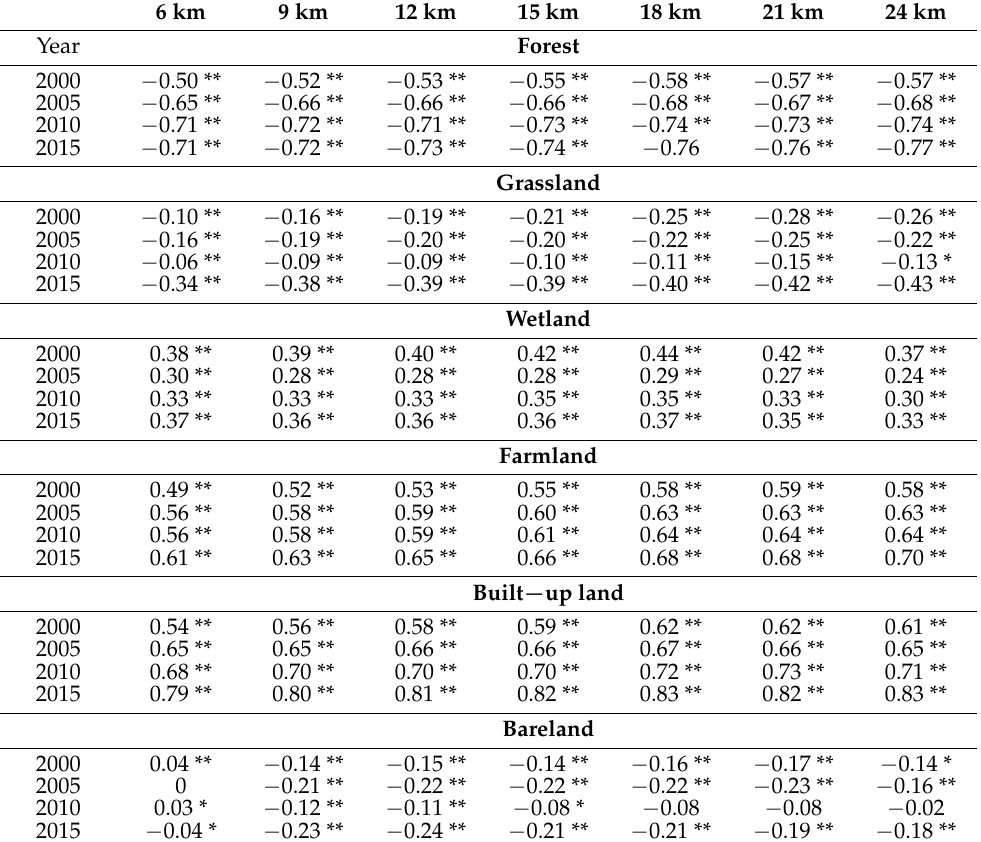
Table 2. The Spearman correlation coefficients for the land cover density and land surface temperature (LST) across different grid sizes and periods (** p < 0.01 level and * p < 0.05